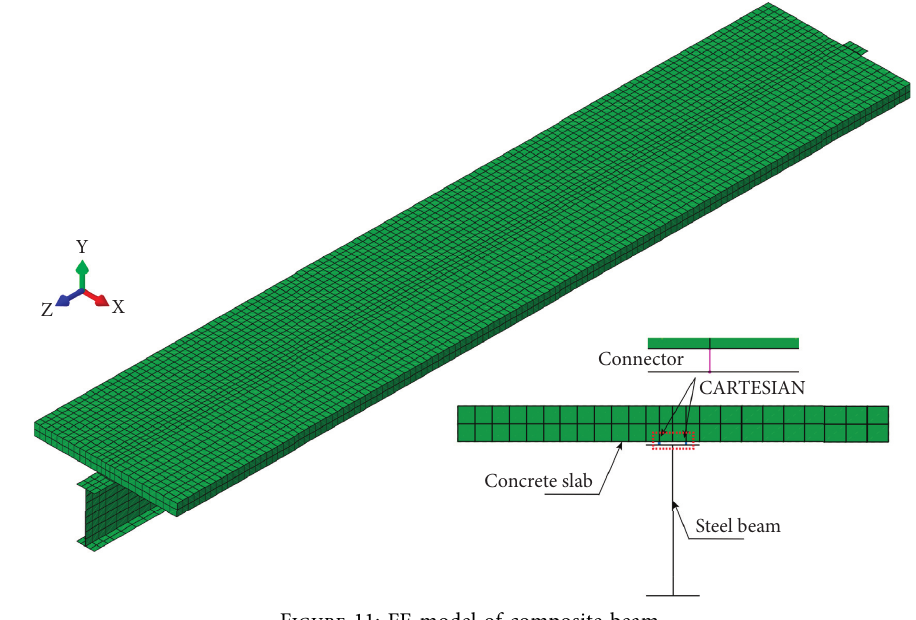
Figure 11: FE model of composite beam.